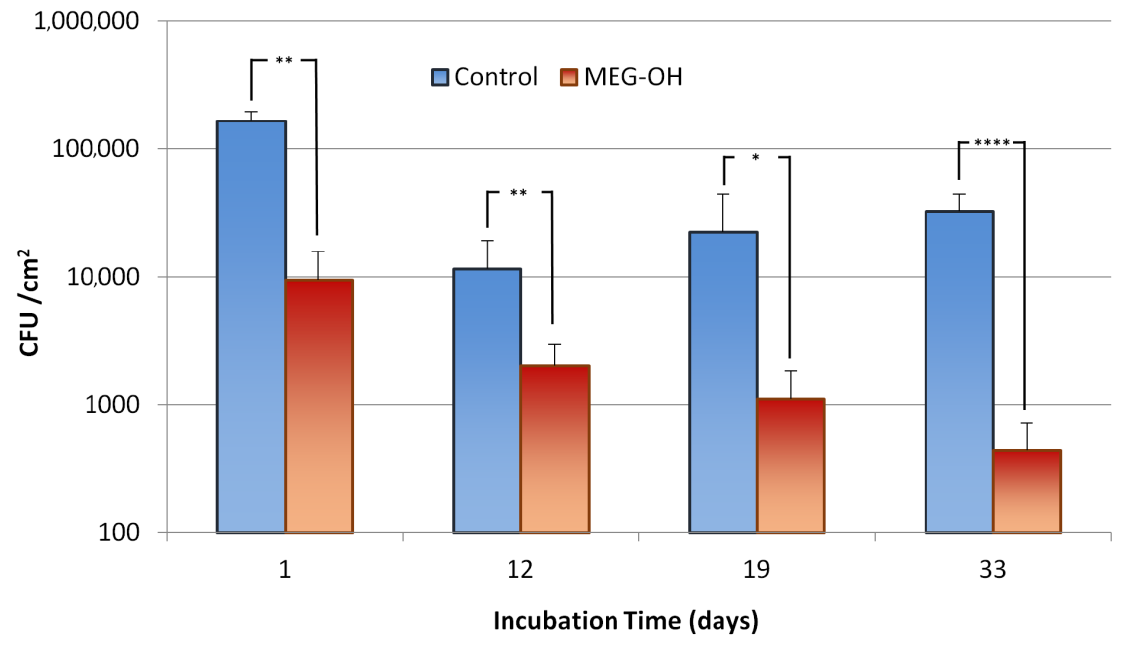
Figure 4. Comparison of CFU counts of S. aureus growing on control (blue) and MEG-OH coated (red) polyurethane surfaces at days 1 (static culture), 12, 19, and 33 (under flow of 2 g/L LB medium). Asterisks represent the calculated confidence interval using a two variable t -test (* = 90%, ** = 95%, *** = 98%, and **** = 99%+, n = 6).